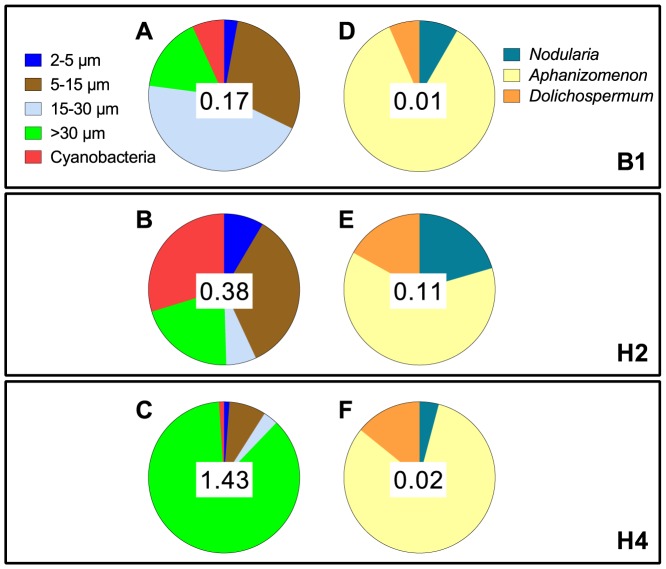
Composition of phytoplankton (A–C) and cyanobacterial (D–F) communities during the study period at: (A, D) stn B1, (B, E) stn H2, and (C, F) stn H4.Number in the middle of each pie chart indicates total biovolume (mm3 L−1) of the contributing categories.